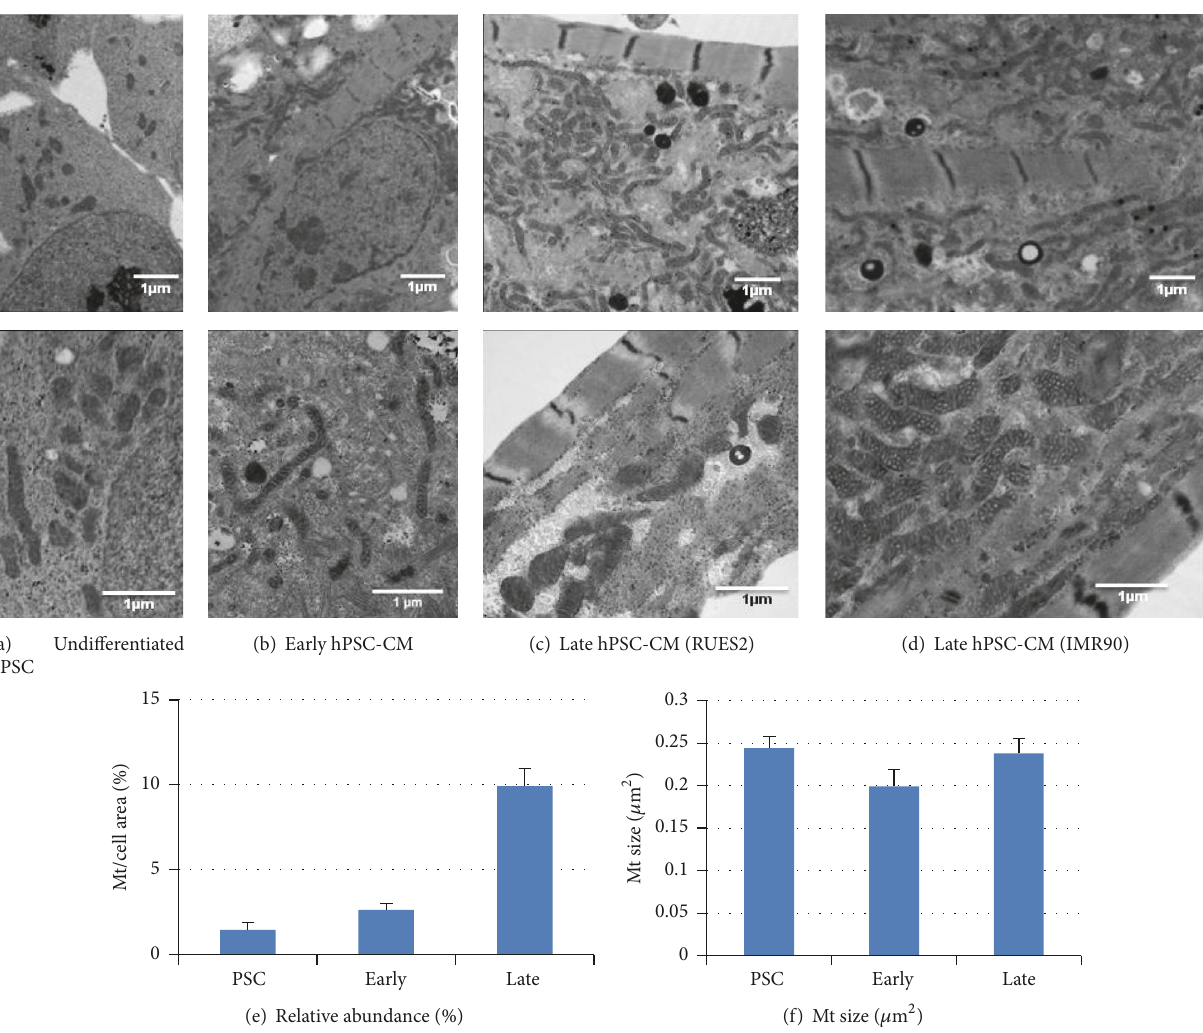
Figure 3: EM images of undifferentiated RuES2 hPSC (a), early stage RuES2 PSC-CM (b), late stage RuES2 PSC-CM (c), and late stage IMR90 iPSC-CM (d) at lower (upper panel) and higher magnification (lower panel). Quantitative analysis of relative abundance of mitochondria (e, calculated by mitochondria area/cell area) and mitochondrial size (f). Data represented as mean ± SEM, 𝑛 = 321 for early stage and 𝑛 = 433 for late stage. Data represented as mean ± SEM. For each condition 16 fields were